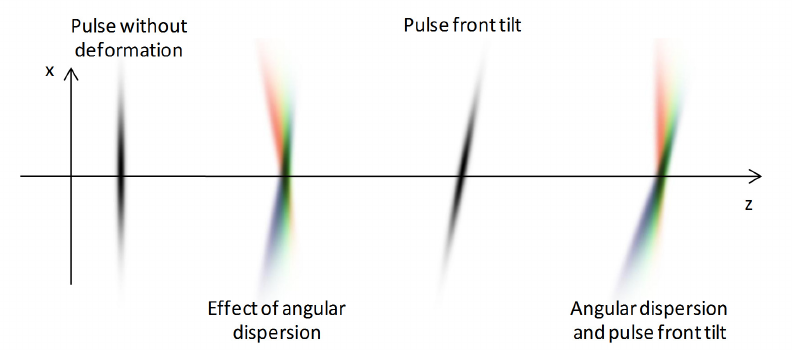
Figure 4. Illustration of spatial effects of the angular dispersion and pulse front